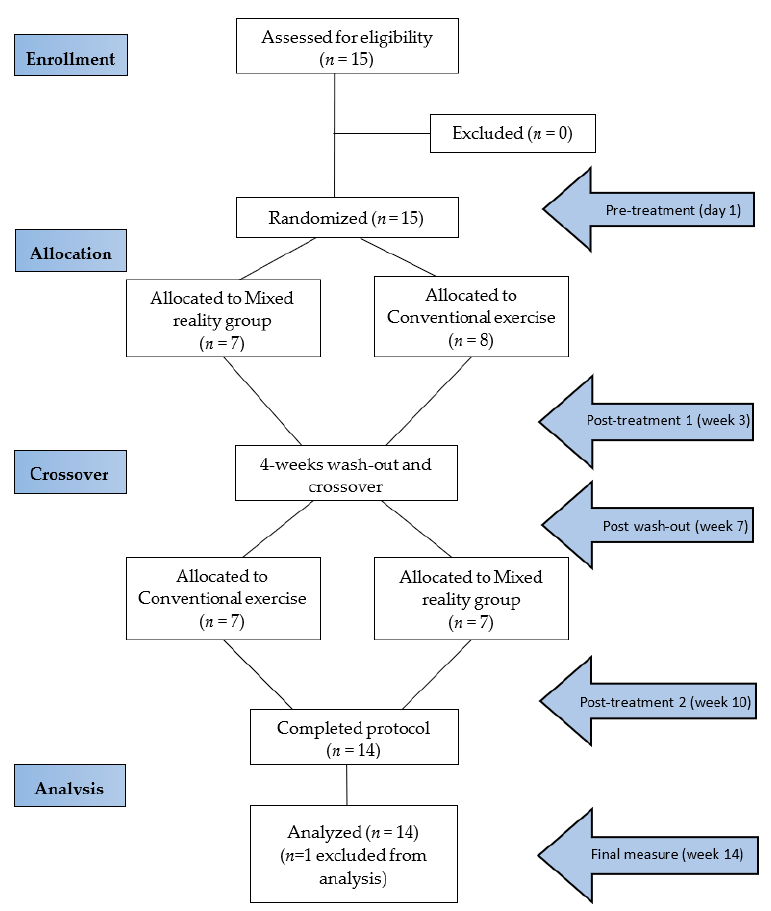
Figure 2. Flow diagram for crossover trial (arrows represent measurements).